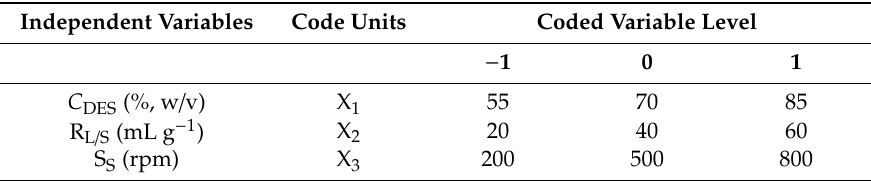
Table 1. The process variables included in the experimental design with the corresponding code units and coded